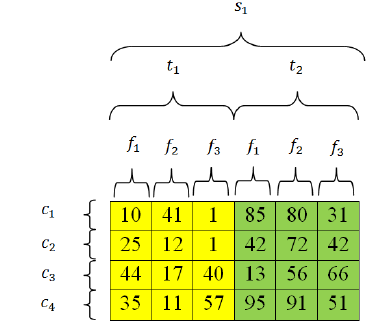
Fig. 1. Chromosome